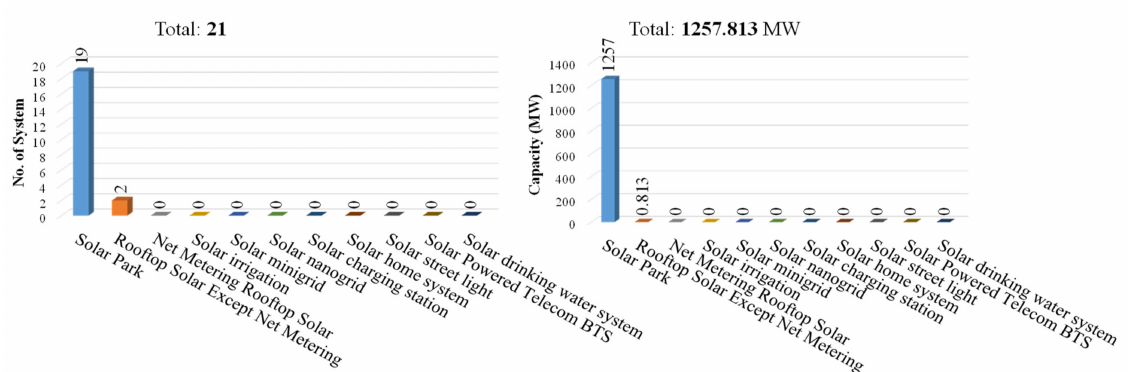
Figure 9. Solar project implementation ongoing, number of systems, and capacity (authors’ creation based on SREDA data [21]).